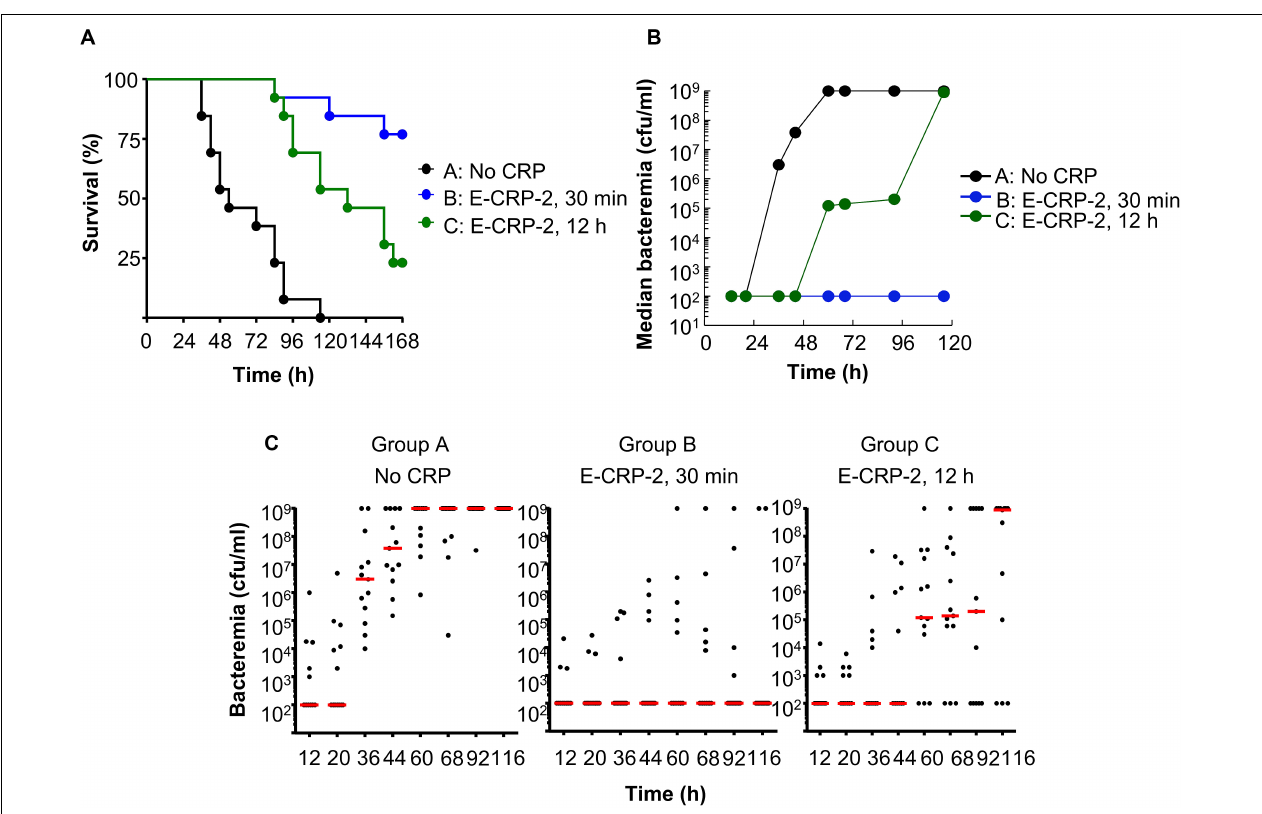
FIGURE 9 | Like E-CRP-1, E-CRP-2 is also protective against late-stage infection. The data are combined from two separate experiments with six to eight mice in each group in each experiment. (A) Survival curves. CRP was injected first; pneumococci were injected either 30 min or 12 h later. The p -values for the differences in the survival curves between groups A C and A B were < 0.001 and between groups B C was 0.01. (B) Bacteremia in each surviving mouse shown in A . The median values of bacteremia are plotted. For 36–116 h, the p -values for the differences between groups A B and A C were < 0.001. The p -values for the differences between groups B C was > 0.05 till 60 h and < 0.05 after 60 h. (C) Scatter plots of the bacteremia data shown in B . The horizontal line in each group of mice represents median